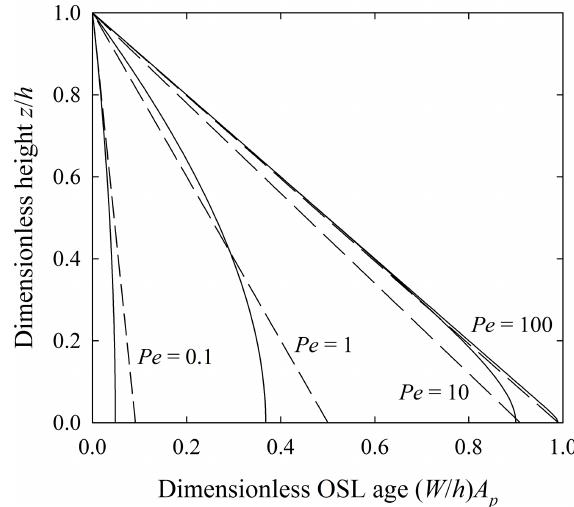
Figure 13. Plot of dimensionless expected particle OSL age ˆ A p ( ˆ z ) = ( W/h ) A p ( z ) versus dimensionless height ˆ z = z/h with uniform mixing (solid lines) and nonuniform mixing (dashed lines) as these vary with the Péclet number Pe = Wh/K z